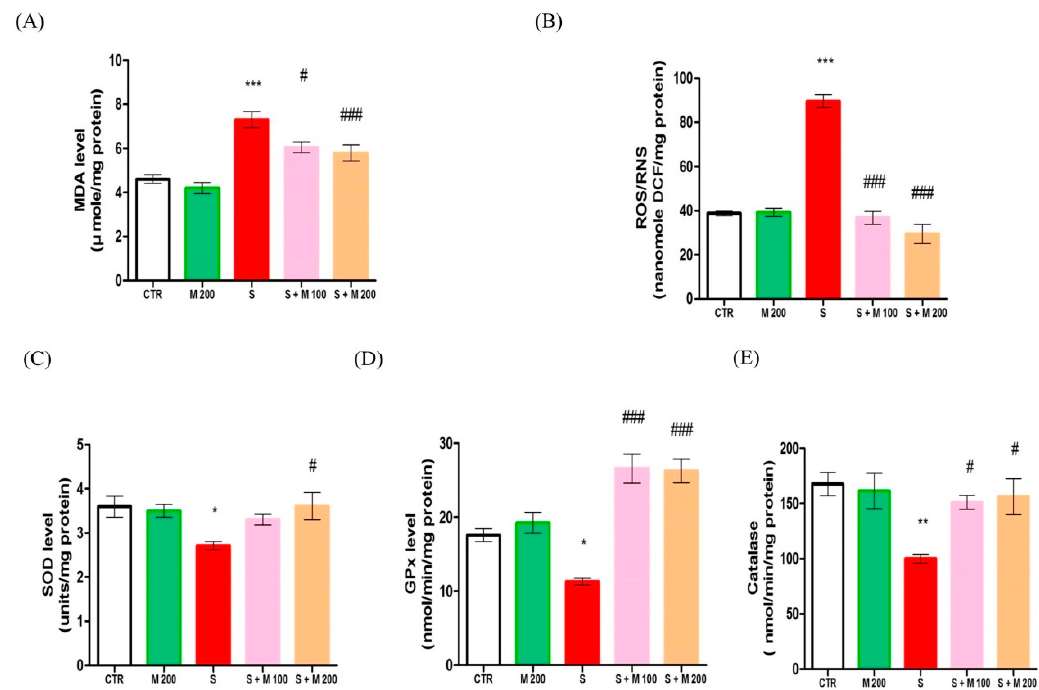
Figure 3. MOTILIPERM treatment attenuates oxidative stress in testis tissue of immobilization stress-treated male Sprague Dawley rats. ( A ) Malonaldehyde levels, ( B ) reactive oxygen